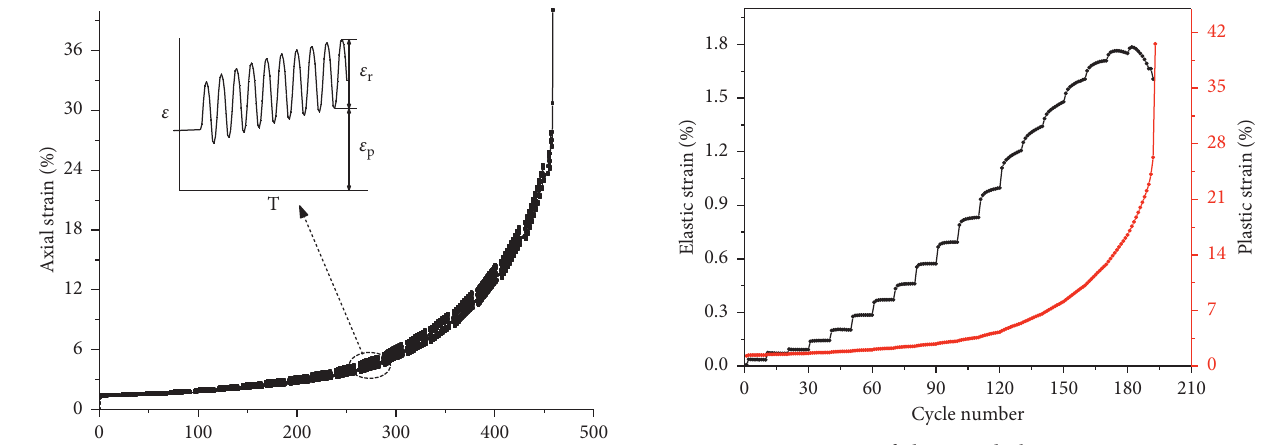
Figure 5: Curves of elastic and plastic strains at